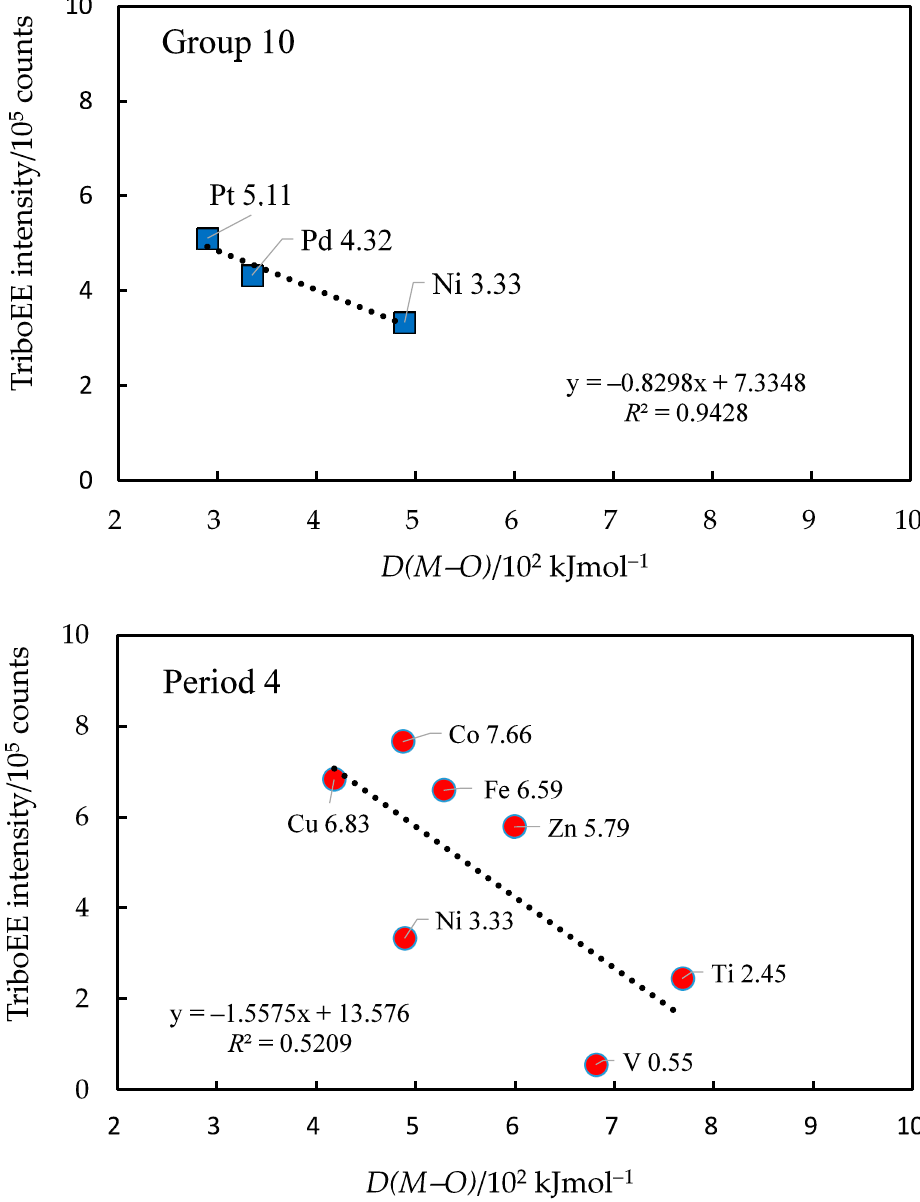
Figure 10. The plots of the TriboEE intensity against D(M–O) values for metals in group 10 and period 4. Furthermore, Figure 10 shows plots of TriboEE intensity against D(M–O) values for the metals in group 10 and period 4. The former was a straight line with a slope of − 0.830 × 10 3 counts/kJ·mol − 1 . Interestingly, this is considered to propose a new method to quanti- tatively estimate the effect of the surface barrier on the TriboEE by the metal ‒ oxygen bond energy of the surface oxide layer. The latter plot for the metals in period 4 shows that, on the whole, the TriboEE intensity tends to increase with decreasing values of D(M–O) , alt- hough the data points are scattered. I think that, in this case, both EE routes tunneling through the barrier (for Fe, Co, Ni, Cu, and Zn) and passing over the barrier height (for Ti and V) are included, but the former, owing to the lowering of D(M–O) values, appears stronger than the latter because of the reduction in the WF or photothreshold, resulting in an increase in TriboEE intensity with decreasing D(M–O) values. The relationship be- tween the D(M–O) and XPS results and the TriboEE intensity is described in more detail later.